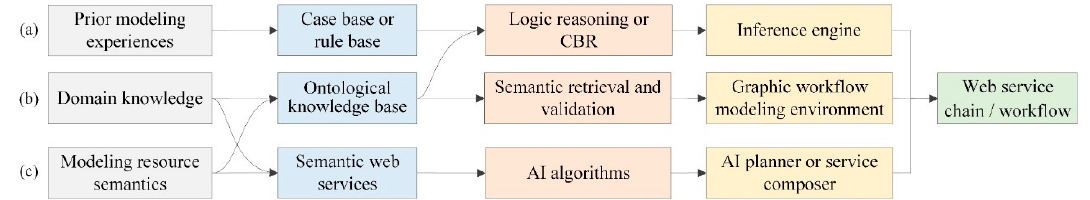
Figure 4. Intelligent building of input data preparation workflow: ( a ) Knowledge-supported interactive workflow building, ( b ) knowledge-driven (semi-)automatic workflow building, and ( c ) automatic web service composition based on AI planning.